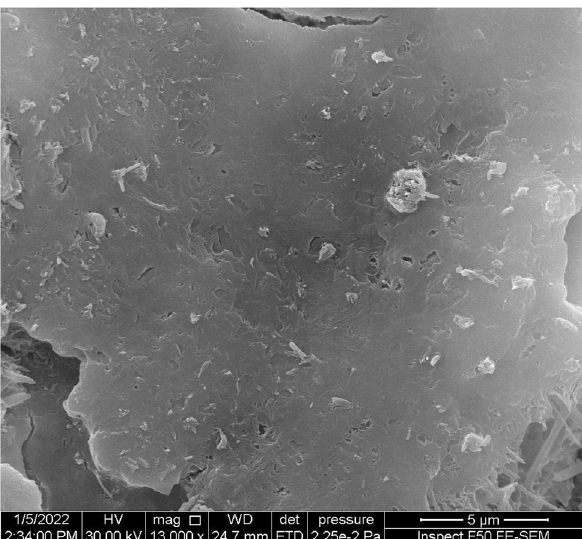
Figure 4: FESEM of sample A5 porcelanite concrete magni fi ed 13,000 ×